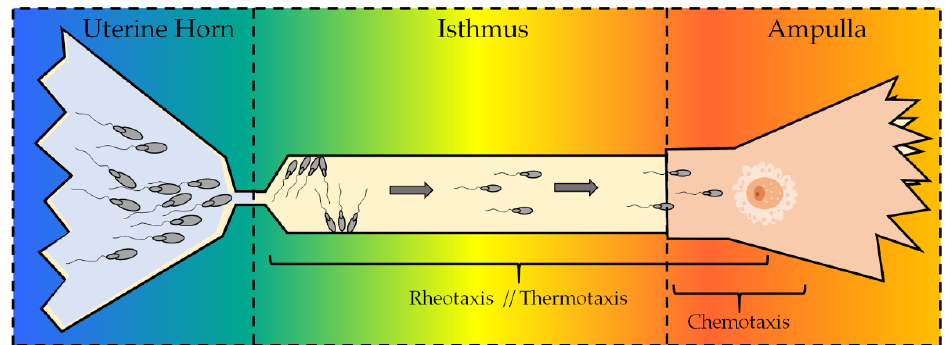
Figure 5. Female oviduct and sperm migration. The diagram shows the female tract of mammals and the three sperm guidance mechanisms, depending on the site in which they have been described to act. While rheotaxis and thermotaxis have been suggested to act mostly in long-range distances, chemotaxis is supposed to take place only in the proximity of the female egg (considering that the exact fertilization site is species-dependent). The colors represent the thermal and chemical gradient (from left to right).